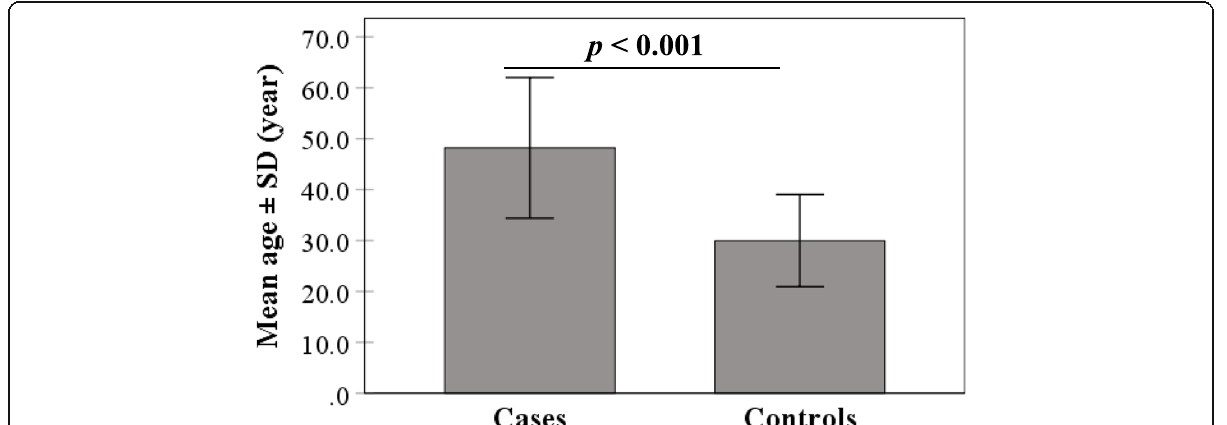
Fig. 1 Mean age of COVID-19 cases and